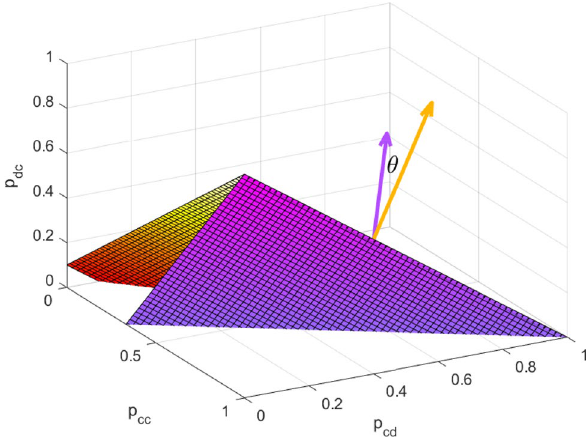
Figure 2. The form of θ in the IPD game with misperception. Consider ω 1 = [ T 1 , R 1 , P 1 , S 1 ] = [ 5, 3, 1, 0 ] and , 6, 1, 0 ] . Suppose p 0 since it does not influence nonzero canonical angles. The ω 2 = [ T 2 , R 2 , P 2 , S 2 ] = [ 13 dd = 2 purple (yellow) plane is the available ZD strategy set in G 1 ( G 2 ) and the purple (yellow) vector is its normal vector. Clearly, θ is the angle between two normal vectors, which is also the nonzero canonical angle between the available ZD strategy set of G 1 and it of G 2